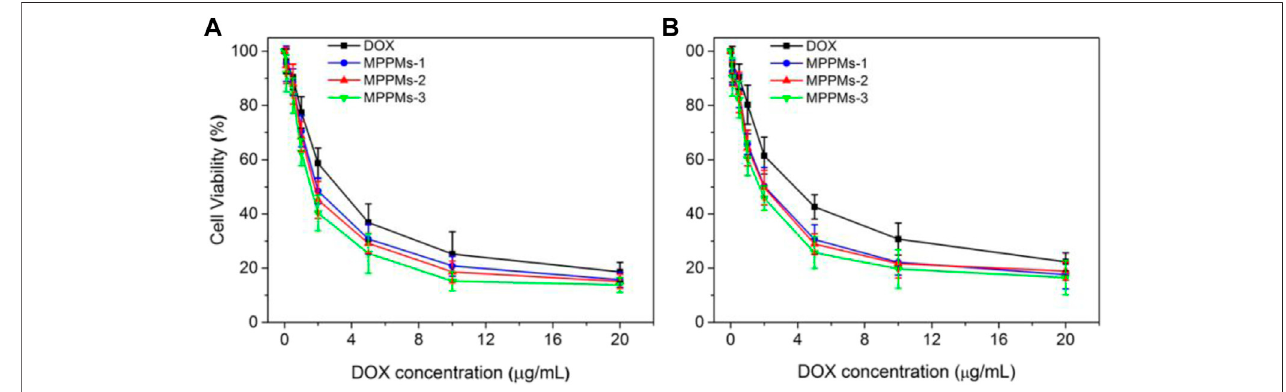
FIGURE 6 | The cytotoxicity for A549 (A) and MDA-MB-231 (B) cells treated with free DOX, MPPMs-1, MPPMs-2, and MPPMs-3 formulation for 24 h in concentration speci fi ed ( n = 6, mean ± SD).